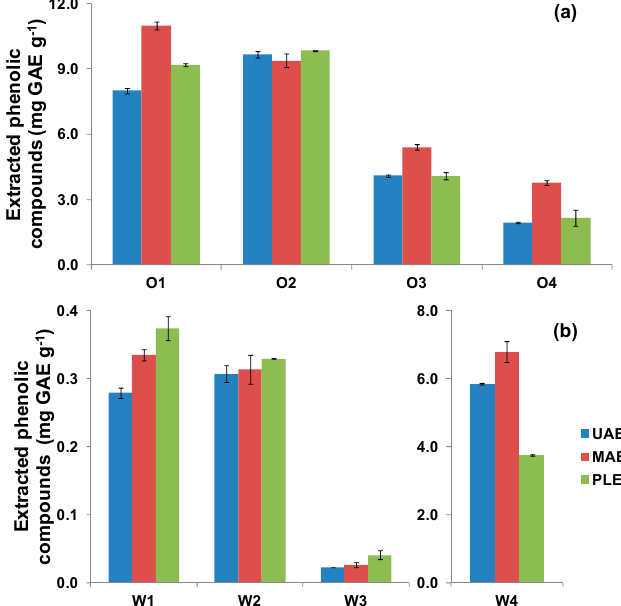
Figure 6. Extraction techniques comparison in olive mill ( a ) and winery ( b ) residues.